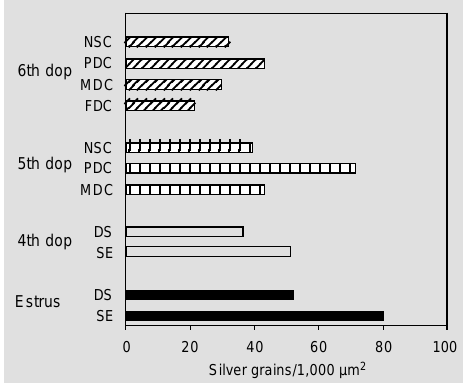
Figure 2 - Incorporation of 35 S by mouse endometrial stromal cells during estrus and on days 4, 5 and 6 of pregnancy (dop). In nonpregnant mice and 4-day pregnant animals the silver grains were counted over cells of the subepithelial region (SE) and of the deep stroma (DS) of the endometrium. At implanta- tion sites the grains were counted over flattened decidual cells (FDC), mature decidual cells (MDC), predecidual cells (PDC), and nondecidualized stroma cells (NSC). The bars rep- resent the average of silver grain counts per 1,000 µm 2